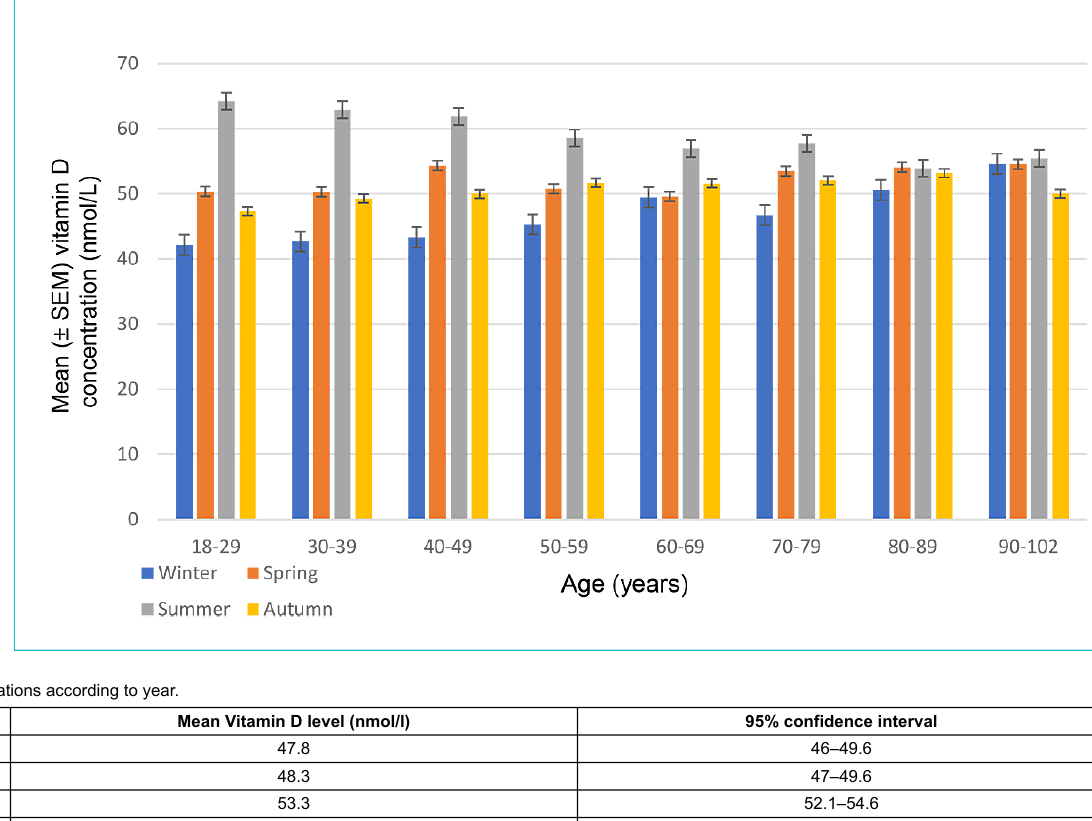
Figure 2: Mean concentrations of vitamin D by age group and season. Error bars represent standard errors of the mean (SEM).